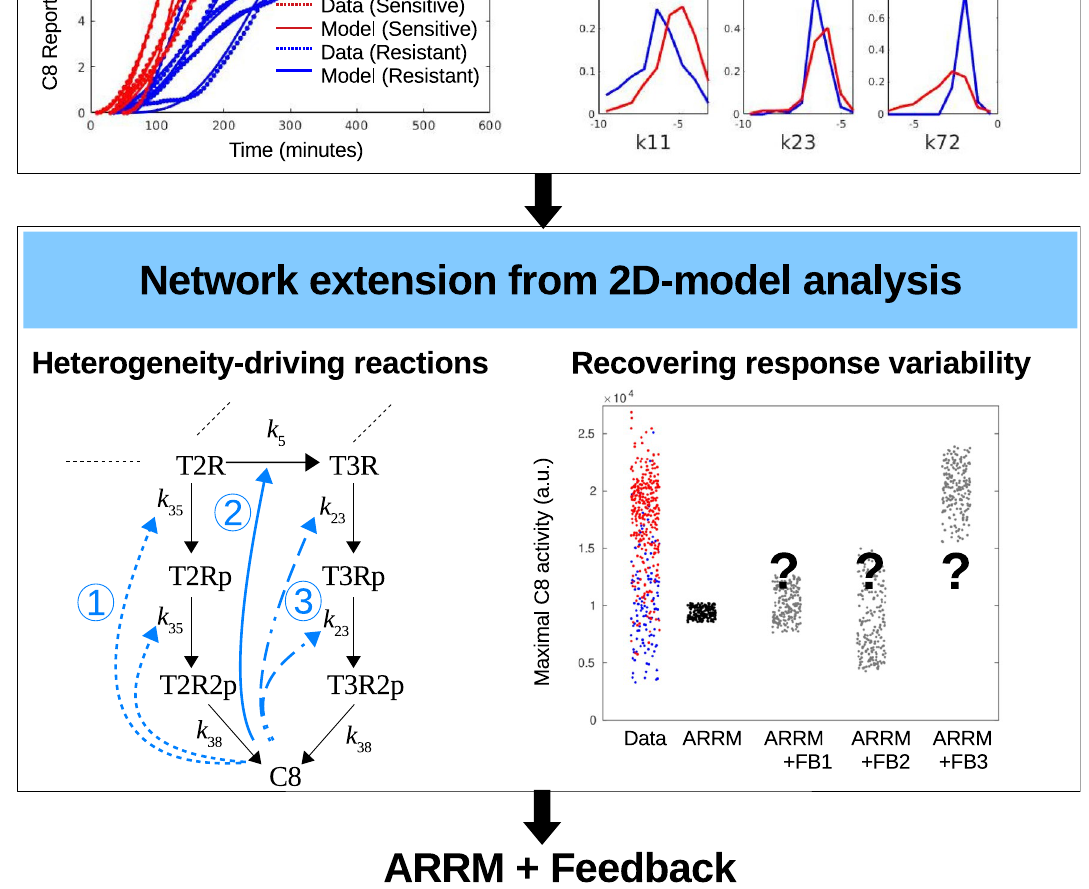
Figure 1. The two-level approach from model development and calibration to network analysis and heterogeneity prediction. Top row: An apoptosis receptor reaction model (ARRM) is first constructed and fitted to experimental single cell trajectories, to obtain parameter sets for every sensitive (red curves) and resistant (blue curves) cells. Comparison and ranking of parameter distributions indicates a small subset of reactions (five out of 32) distinguishing between drug response phenotypes. Bottom row: Since ARRM is not sufficient to explain the variability observed in experiments in response to 20% variation in initial conditions (measured by the maximal slope of C8 Reporter FRET signal, a proxy for maximal C8 activity 7 ), we analyse the signaling network with extra regulatory processes, in the form of a positive feedback loop from one of the main proteins to a key heterogeneity-driving reaction identified previously. Theoretical analysis of a 2-dimensional (2D) model, predicts the network configurations which are capable of generating large heterogeneity as a function initial conditions only. Each set of light blue arrows (dashed, solid, or dash-dotted) forms a possible configuration of the extended ARRM+Feedback model. The new feedback configurations are also fitted to single cell data and tested for their capacity to generate large response